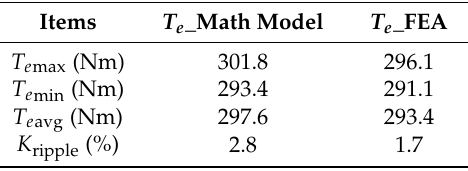
( c ) ( d ) Figure 10. Prototype of proposed 18-slot/8-pole FMPM machine. ( a ) Outer rotor; ( b ) stator; ( c ) prototype assembly; and ( d ) experimental setup.